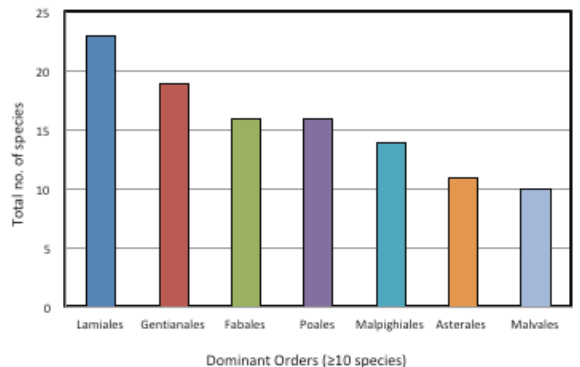
Figure 2. Major contribution of orders (≥ 10 species) in the study area.